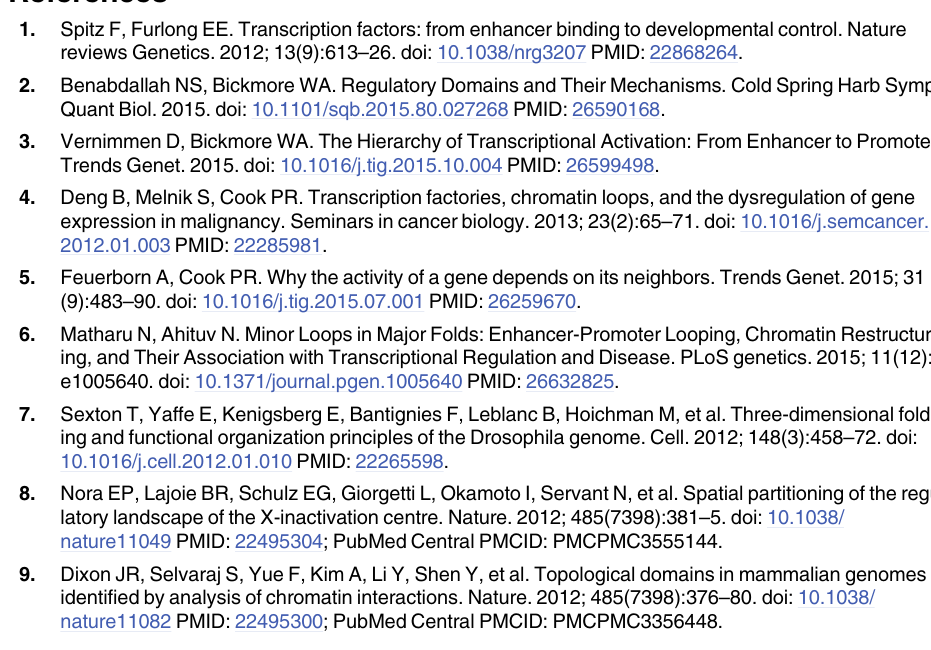
S1 Table. Antibodies used for ChIP-PCR. S2 Table. Primers used for qPCR to quantitate the level of histone marks. (XLSX) S3 Table. Primers used in qRT-qPCR. immunoprecipitation. (XLSX) S4 Table. Primers used for cloning genomic regions corresponding to PIWIL2 canonical promoter in exon 1, PIWIL2 alternative promoters in exons 5 and 7, and promoters of genes PHYHIP , POLR3D , PPP3CC and KIAA1967